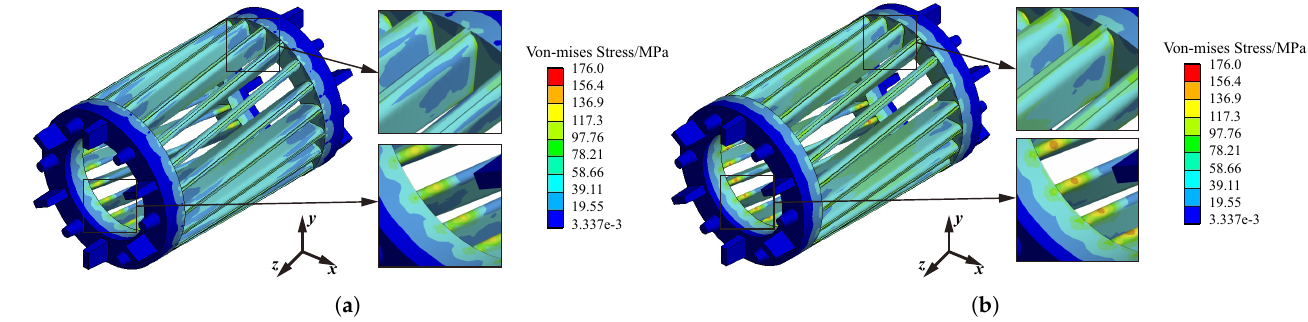
Figure 14. Von Mises stress distribution of squirrel cage rotor before and after the fault. ( a ) Normal. ( b ) Forty-five-turn